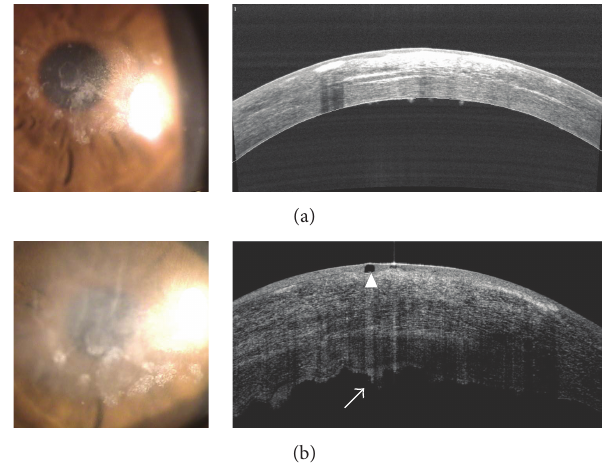
Figure 9: Herpetic keratitis with granular corneal dystrophy. In HSV keratitis with underlying granular corneal dystrophy, AS-OCT images (b) allowed the precise localization of microcystic edema (arrow head) and keratic precipitate (arrow) compared to baseline